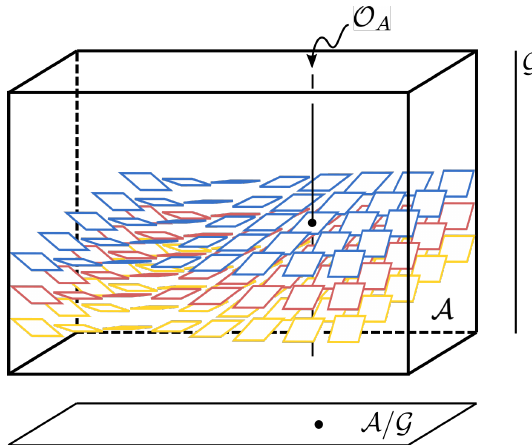
Figure 3: Pictorial representation of anholonomic horizontal plances in A , corre- sponding to a non-vanishing curvature F (cid:54) =